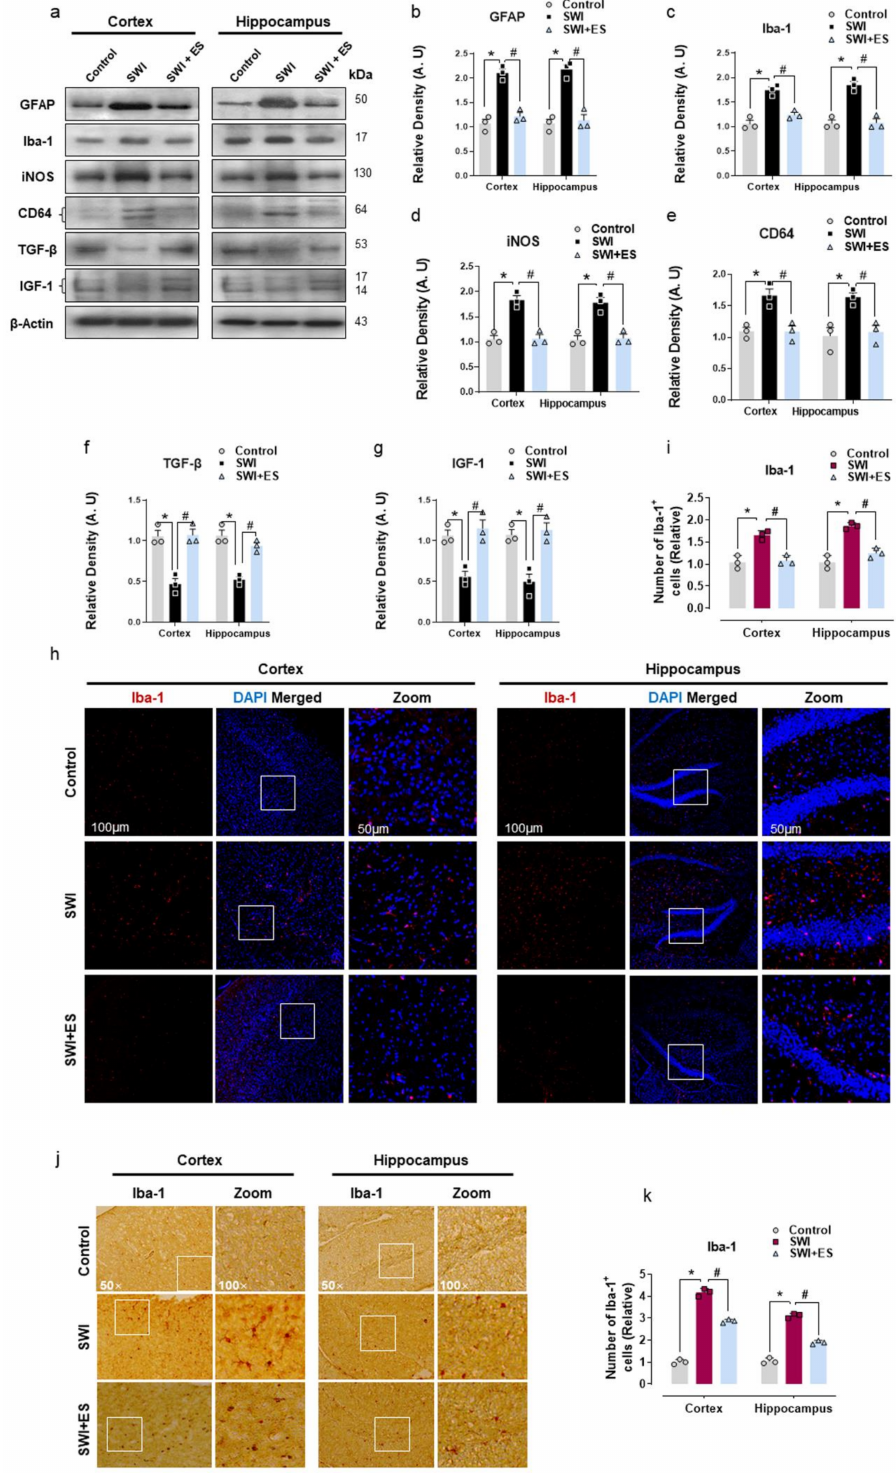
Figure 2. 17- β estradiol (ES) impedes gliosis and brain inflammation after SWI. ( a – g ) Western blot analysis showing protein expression of GFAP, Iba-1, CD64, TGF- β , and IGF-1 in the experimental